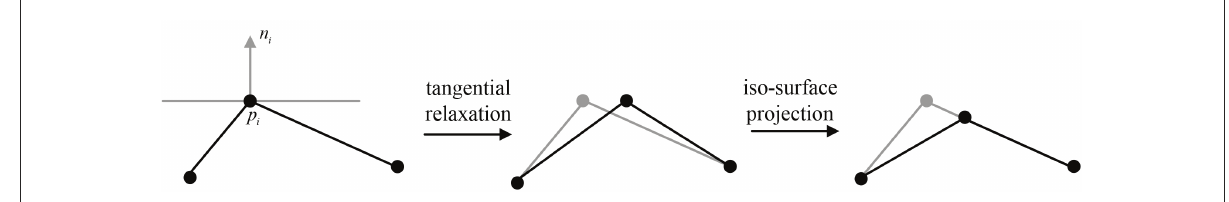
FIGURE8 A 2D illustration for the update of p i ’s position by tangential relaxation and iso-surface projection.